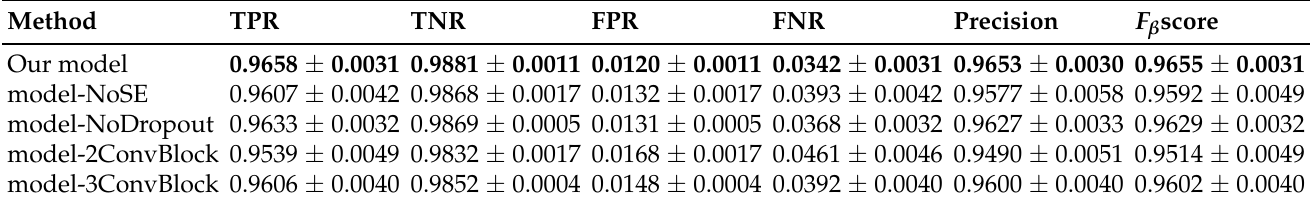
Table 14. The performance of the ablation study on the combination of the two public datasets by 5-fold cross-validation.